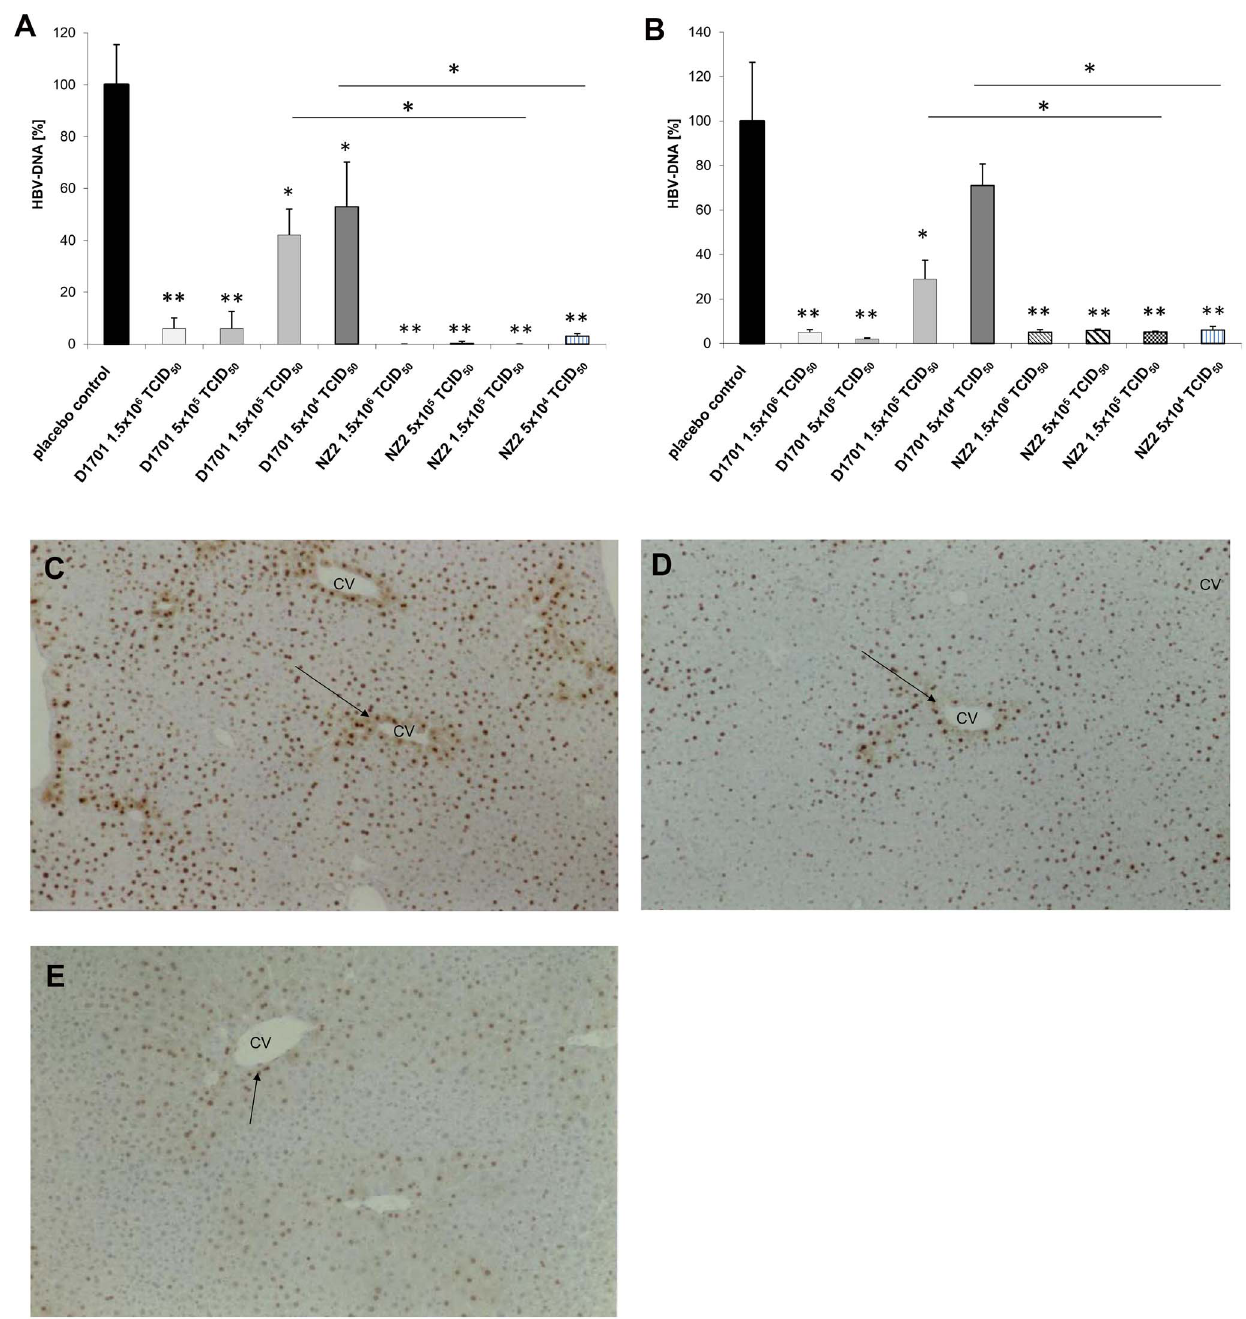
Figure 1. iORFV NZ2 is a more potent inhibitor of HBV than strain D1701 in HBV-transgenic mice. iORFV D1701, iORFV NZ2 or placebo was administered i.p. every third day, three times in total, to HBV-transgenic mice expressing 10 7 –10 8 HBV genome equivalents per ml plasma (n=7 per group). HBV-specific DNA from plasma was analyzed by quantitative PCR and from livers by dot-blot hybridization as described previously [11,18]. The figure shows means 6 standard error of means (SEM) relative to placebo-treated animals where mean HBV-DNA content was set 100%. Treatment with iORFV reduced non-chromosomal HBV-DNA in the livers as compared to placebo animals (a) and in the plasma with the exception of the lowest dose of iORFV D1701 (b) . iORFV NZ-2 was more potent in terms of its potential to inhibit HBV replication compared to strain D1701 with the two lower dosages resulting in significantly higher reduction of HBV-DNA (one-way ANOVA and post hoc analysis [Newman-Keuls Multiple Comparison Test] *p , 0.05, **p , 0.01). c) Immunohistological analysis of HBcAg expression in the livers of placebo-treated animals. Diffuse cytoplasmic staining in periportal areas [arrows, central veins (CV)] indicates viral capsids and ongoing HBV replication in placebo-treated mice. Cytoplasmic HBcAg as well as nuclear HBcAg-specific stain (for empty capsids) was strongly reduced in both iORFV (NZ2)-treated d) and iORFV (D1701)-treated mice e) . Figures provide typical examples of the respective group of animals treated with a dose of 1.5 6 10 6 TCID 50 iORFV NZ 2 or D1701, respectively.